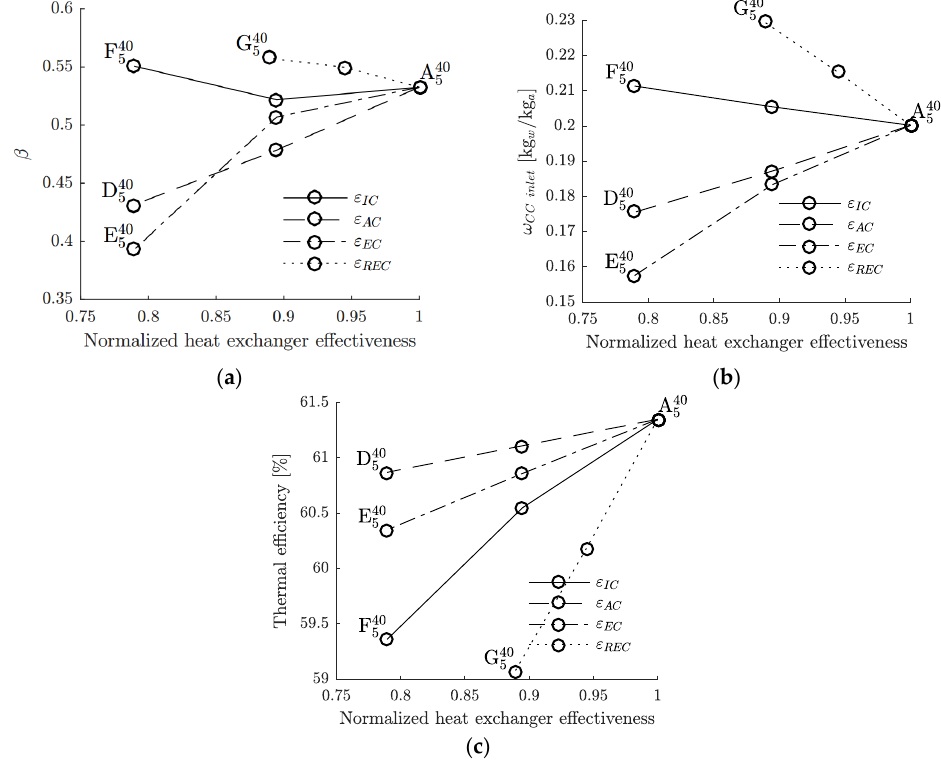
Figure 5. ( a ) normalized heat exchanger effectiveness vs. mass flow fraction through the saturator and aftercooler; ( b ) normalized heat exchanger effectiveness vs. absolute humidity at the inlet of the combustion chamber; and ( c ) normalized heat exchanger effectiveness vs. cycle thermal efficiency— OPR = 40 & ∆ T ps = 5